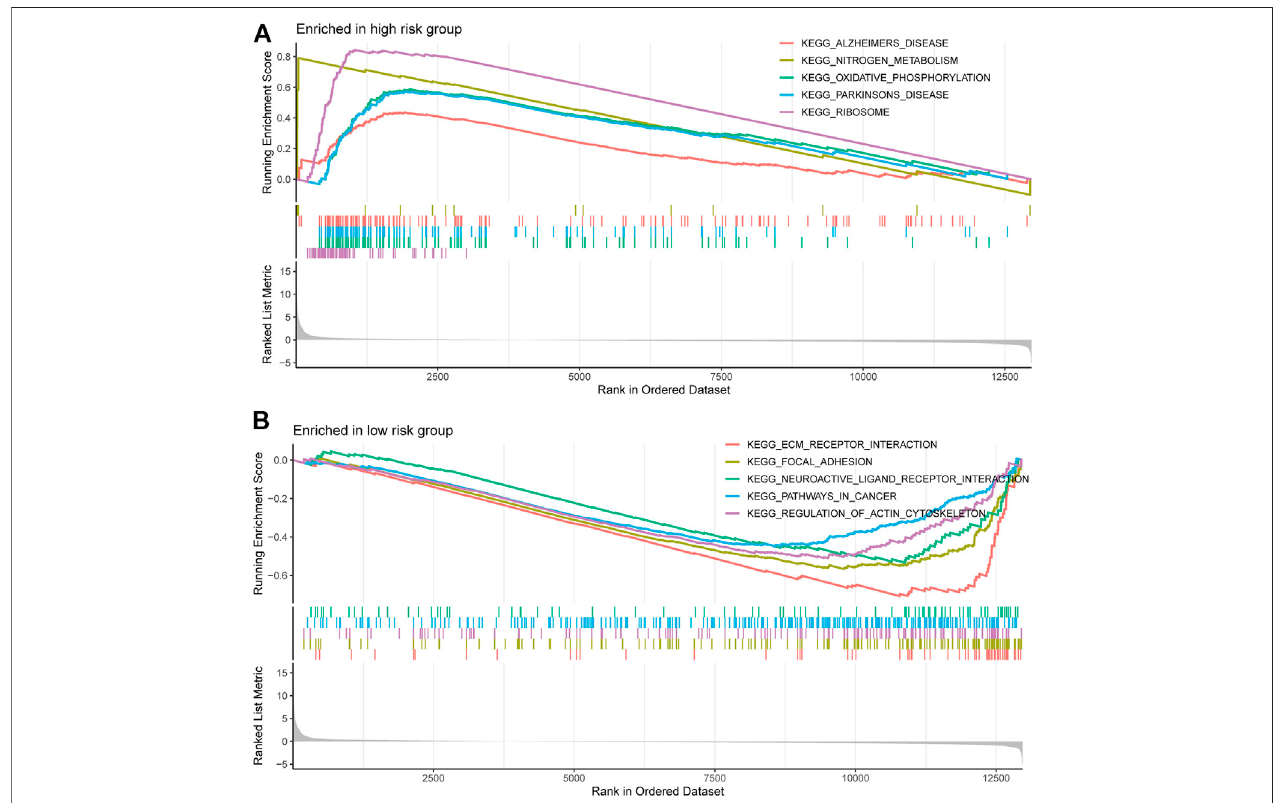
FIGURE 7 | Gene and enrichment analysis of different risk groups. (A) KEGG-enriched pathway in the high-risk group ( p < 0.05 and fdr-adjusted q < 0.05). (B) KEGG-enriched pathway in the low-risk group ( p < 0.05 and fdr-adjusted q < 0.05).